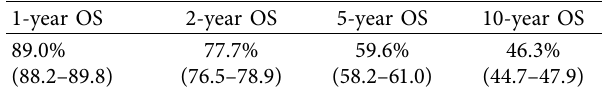
Table 5: OS at 1, 2, 5, and 10 years along with 95% confidence interval for grades II and III resected soft tissue sarcoma in the Netherlands between 2000 and 2017.